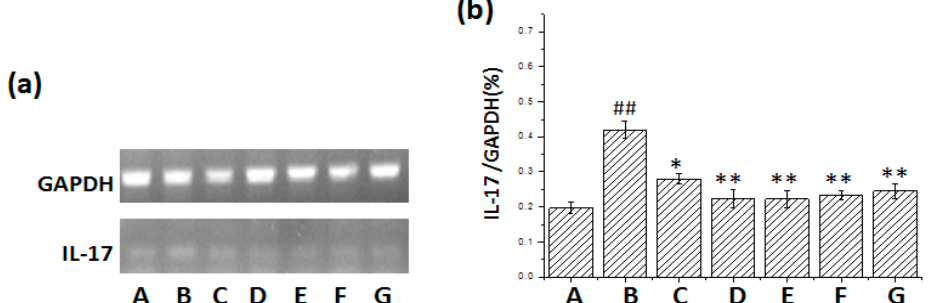
Figure 4. Effect of m KG on the mRNA Expression of IL-17 in the lung tissues of BLM-induced pulmonary fibrosis mice. ( a ) The mRNA expressions of IL-17 in the lung tissues were detected by RT-PCR; ( b ) The semiquantitative result of the IL-17 mRNA expression. Data were expressed as mean ± S.D. ## p < 0.01 compared with the control group. * p < 0.05, ** p < 0.01 compared with the BLM group. (A) Normal group; (B) BLM group; (C) Pirfenidone group; (D) Dexamethasone group; (E) m KG-H group; (F) m KG-M group; (G) m KG-L group.